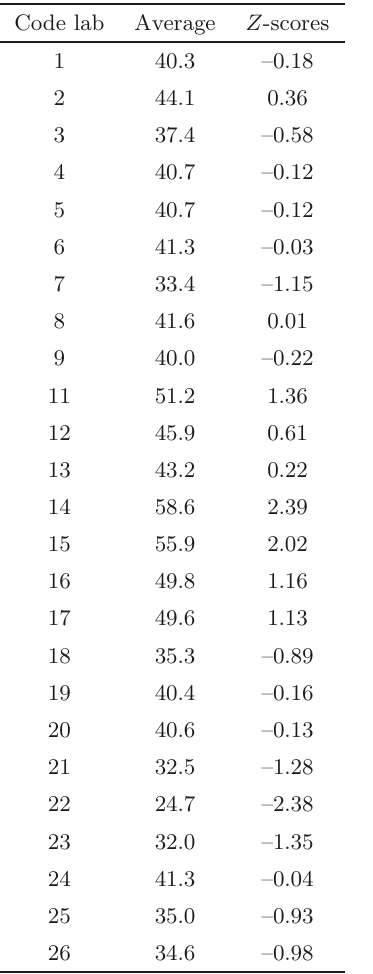
Table 4. Z -score obtained by the laboratories for the his- tamine amount in the level 1 PTS